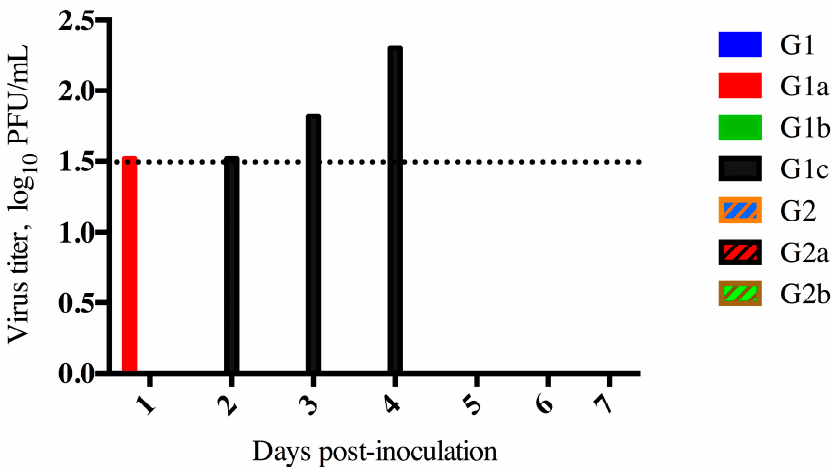
Figure 1. Middle East respiratory syndrome coronavirus (MERS-CoV) shedding in Goats. Virus isolation from nasal swab specimens from experimentally infected goat kids or their co-housed dam. Goat kids 1c and 2a were euthanized day 5 post-infection. The limit of detection for this assay was 1.5 log 10 PFU/mL, indicated as a dashed line.